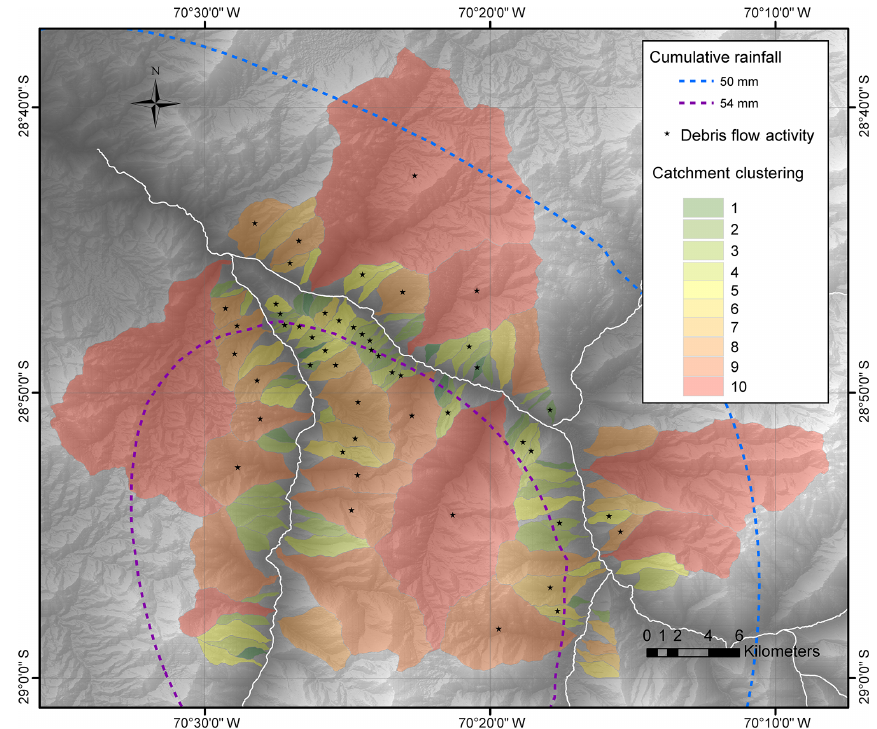
Figure 8. Map of the normalized classification of catchment clustering considering the six topographic attributes (area, length, Strahler order, slope, Melton ratio and relief ratio) involved in conditioning factors of debris flow generation. Topography extracted from a digital elevation model courtesy of NASA JPL Caltech with a nominal spatial pixel resolution of 30m × 30m (https://asterweb.jpl.nasa.gov/gdem.asp, last access: 6 May